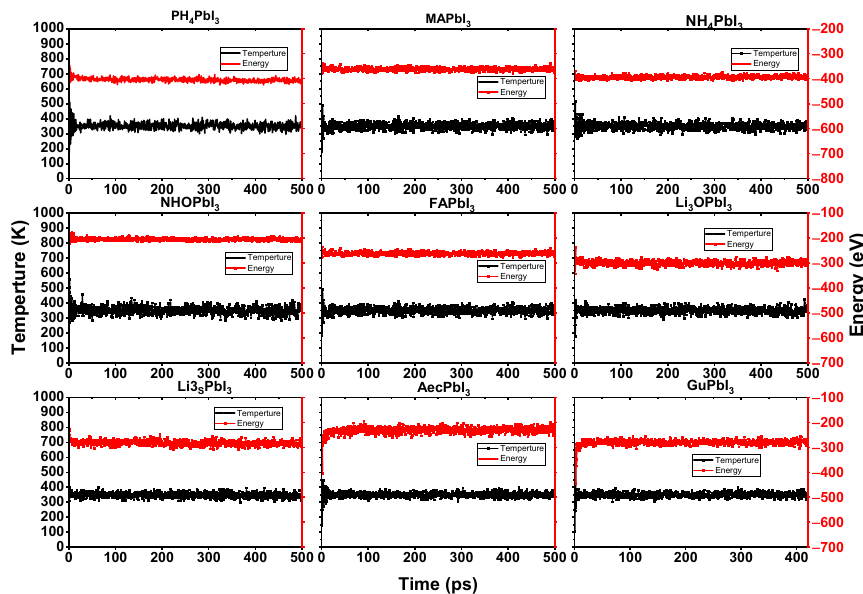
Figure 6. Fluctuation of the temperature and total energy of the considered perovskite systems from 0 to 500 ps using AIMD simulations at 300 K. 0 to 500 ps using AIMD simulations at 300